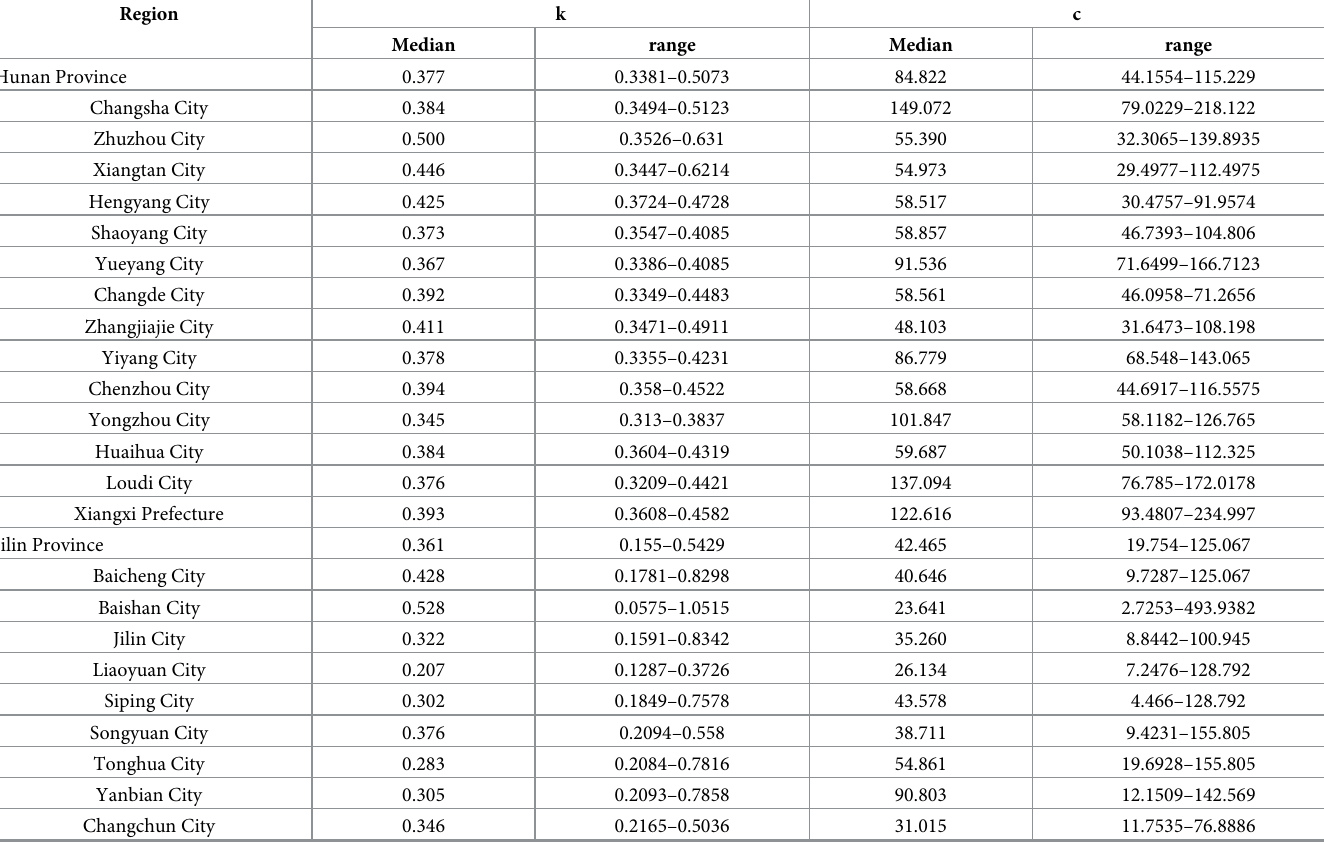
Table 2. Parameters calculated by logistic model to fit the HFMD data in seven areas in China. Region